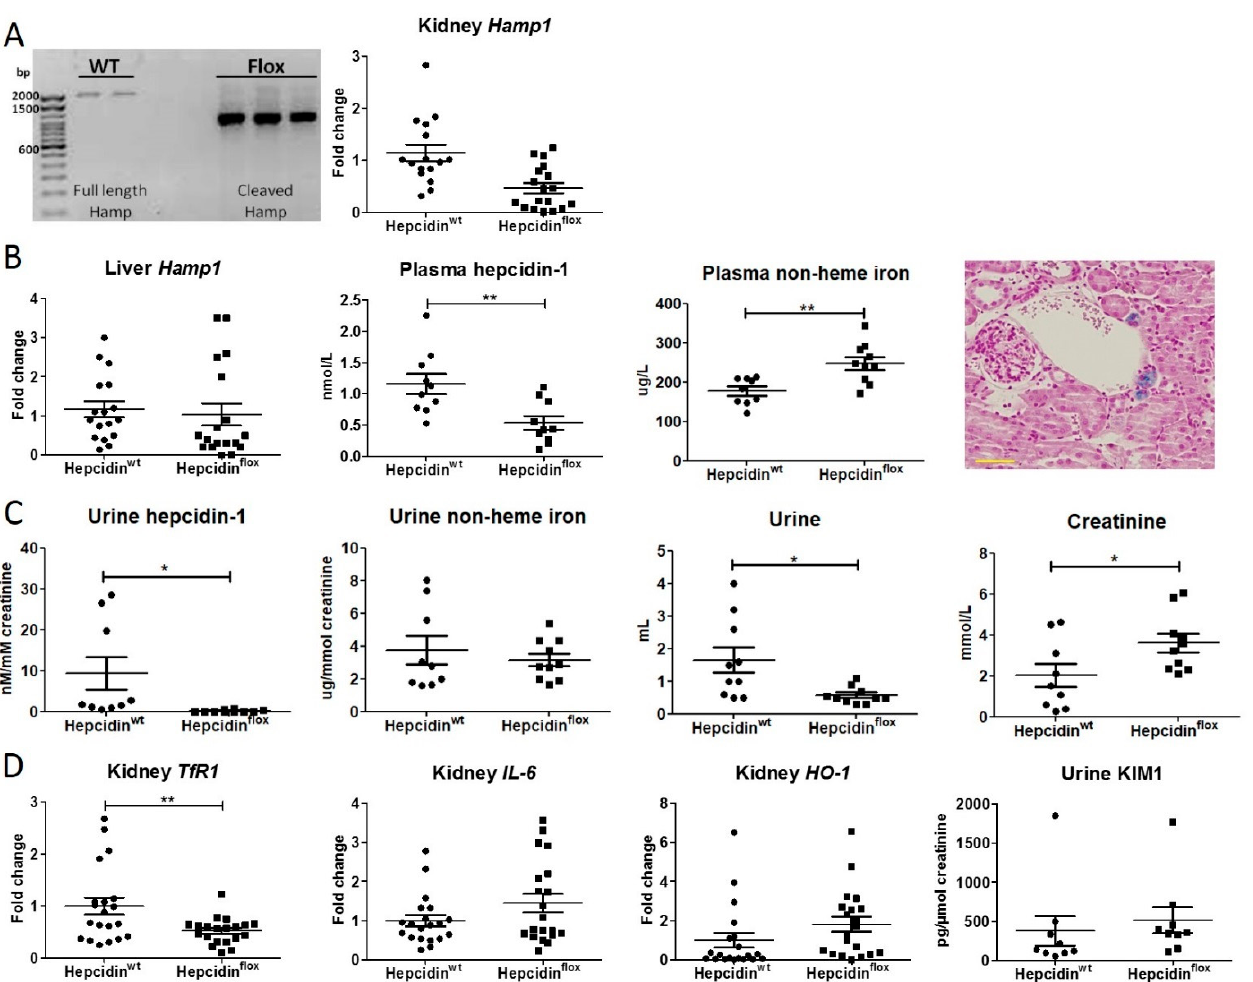
Figure 3. Characterization of renal hepcidin KO in mice. ( A ) PCR gel of renal hepcidin gene amplification and Hamp1 mRNA expression; ( B ) hepatic Hamp1 mRNA expression, plasma hepcidin-1 levels, plasma non-heme iron concentration and representative image of Perls iron staining in hepcidin flox kidney; ( C ) urine hepcidin-1 levels, urine non-heme iron concentration, 24 h urine production, and urine creatinine concentration; and ( D ) renal mRNA expression of TfR1 , HO-1 , IL-6 , and urine concentrations of KIM1 of wild-type and hepcidin KO mice ( n = 10 per group). MRNA expression data is shown in duplicates for each individual mouse. Circles, squares and triangles show individual data points in the indicated treatment group. Graphs show the mean ± SEM. * p < 0.05, ** p < 0.01 using a t -test. Scalebar = 50 µ